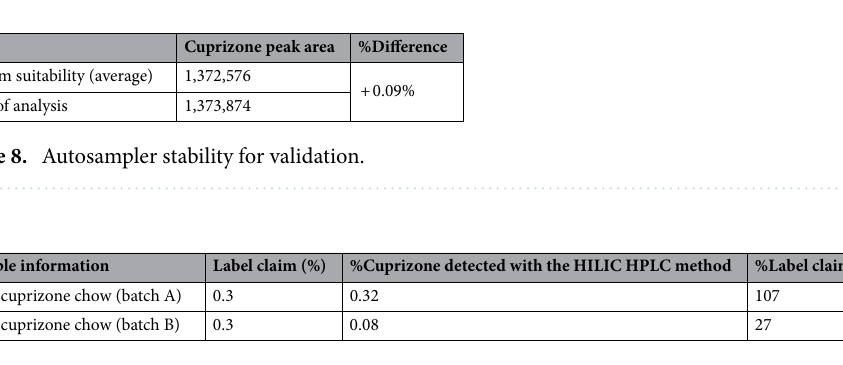
Table 9. Cuprizone amount in the cuprizone-containing chow